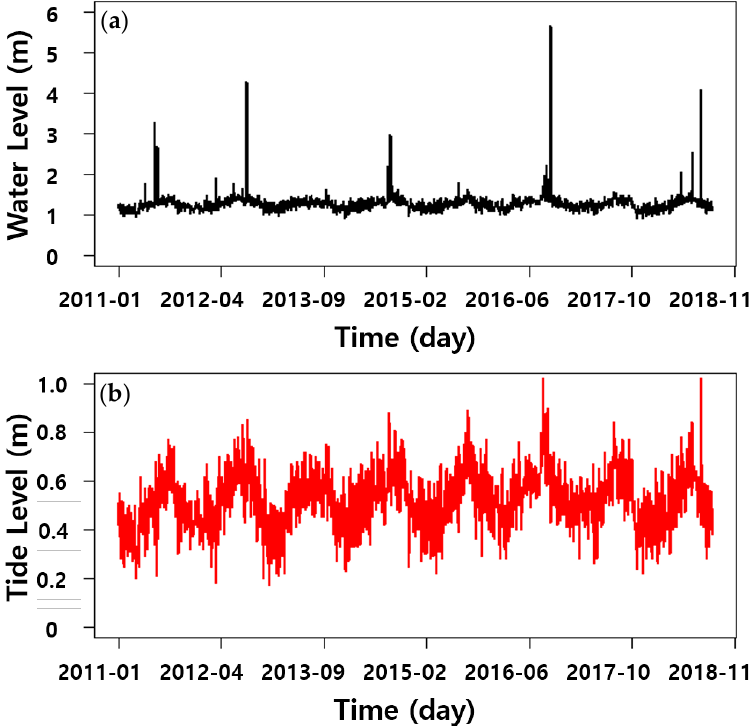
Figure 3. Time series of ( a ) water level in tidal river and ( b ) sea surface level at Ulsan stations.